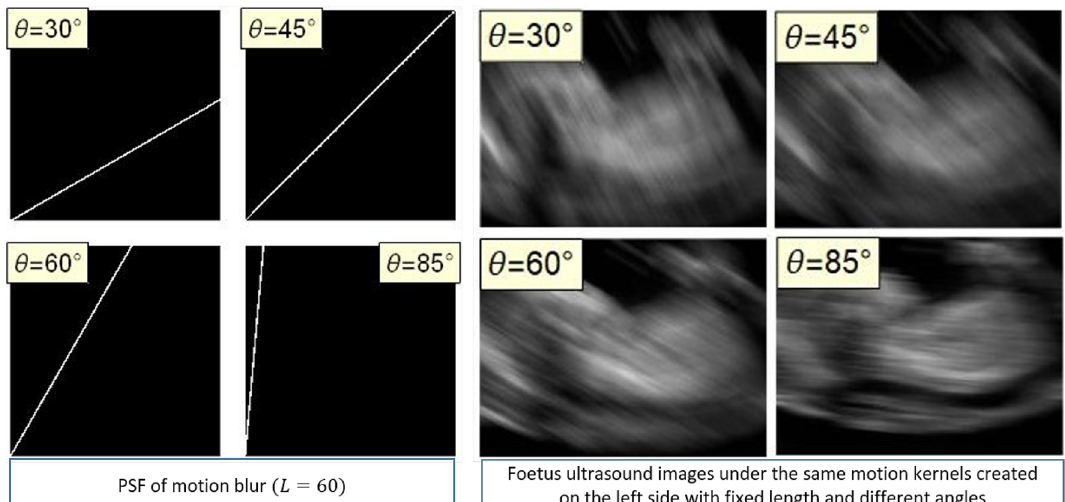
60 and different =